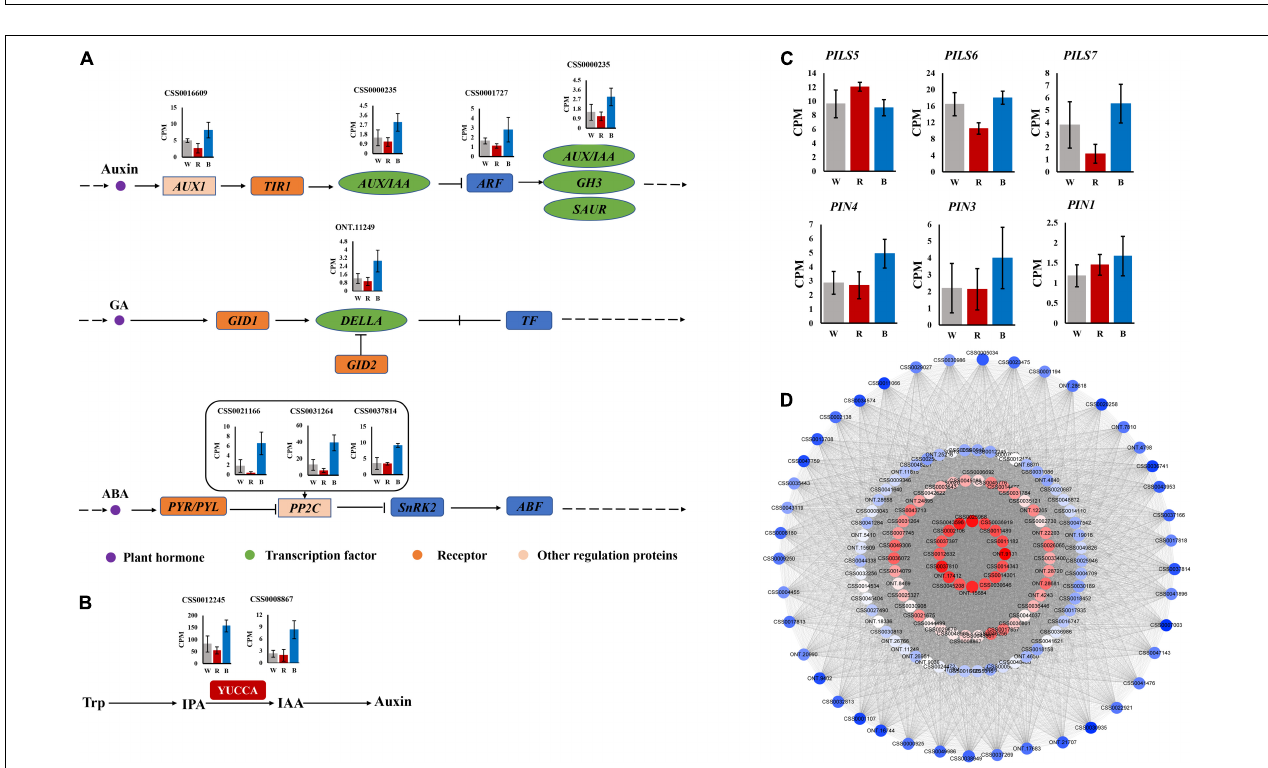
FIGURE 5 | (A) KEGG pathway annotation of genes in the “MEblue” module. Numbers next to the bar graph indicate gene enrichment for this pathway. (B) GO annotations of genes in the “MEblue” module.